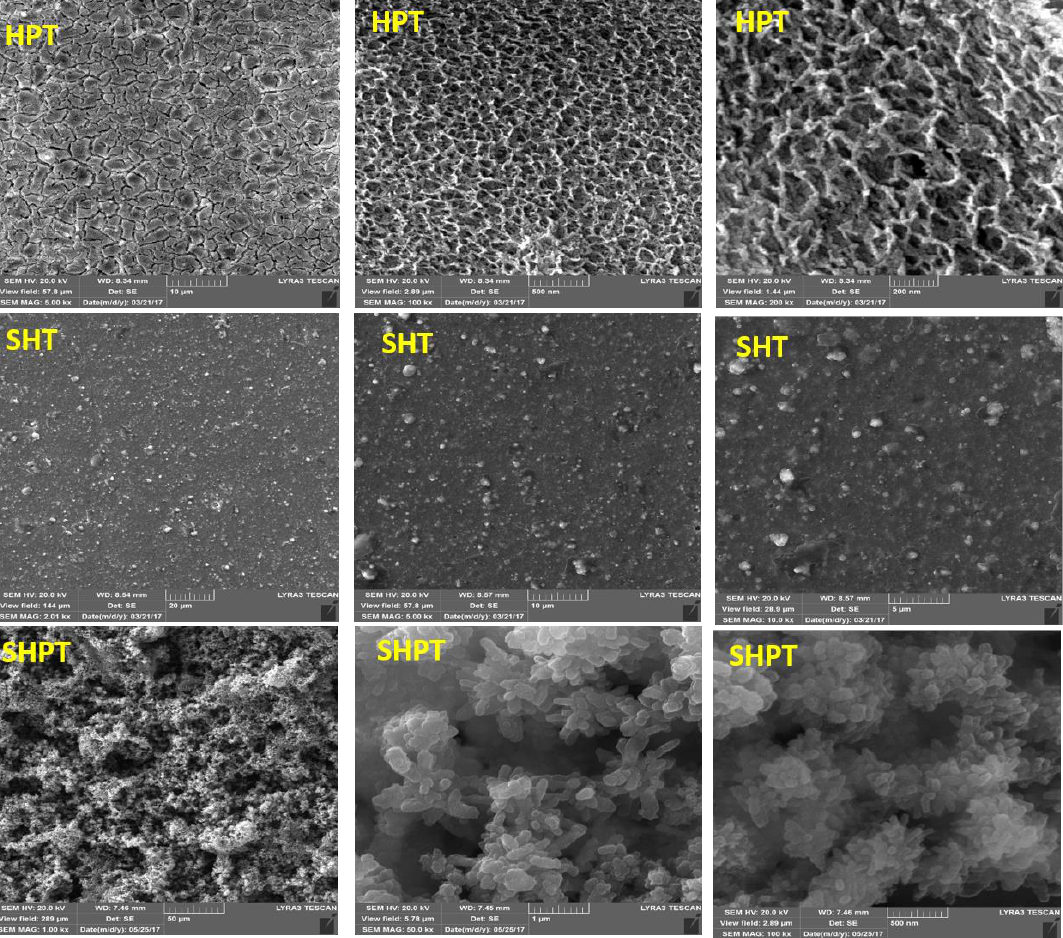
Figure 1. SEM micrographs of treated specimens.